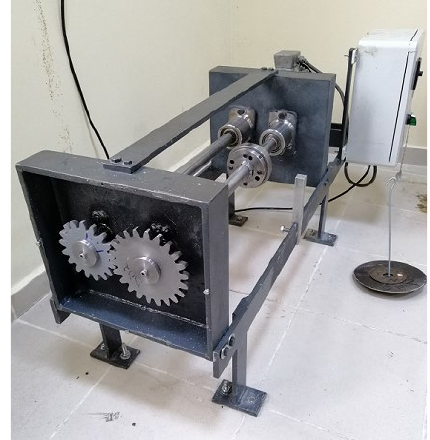
Figure 5. Wear test rig. Figure 5. Wear test